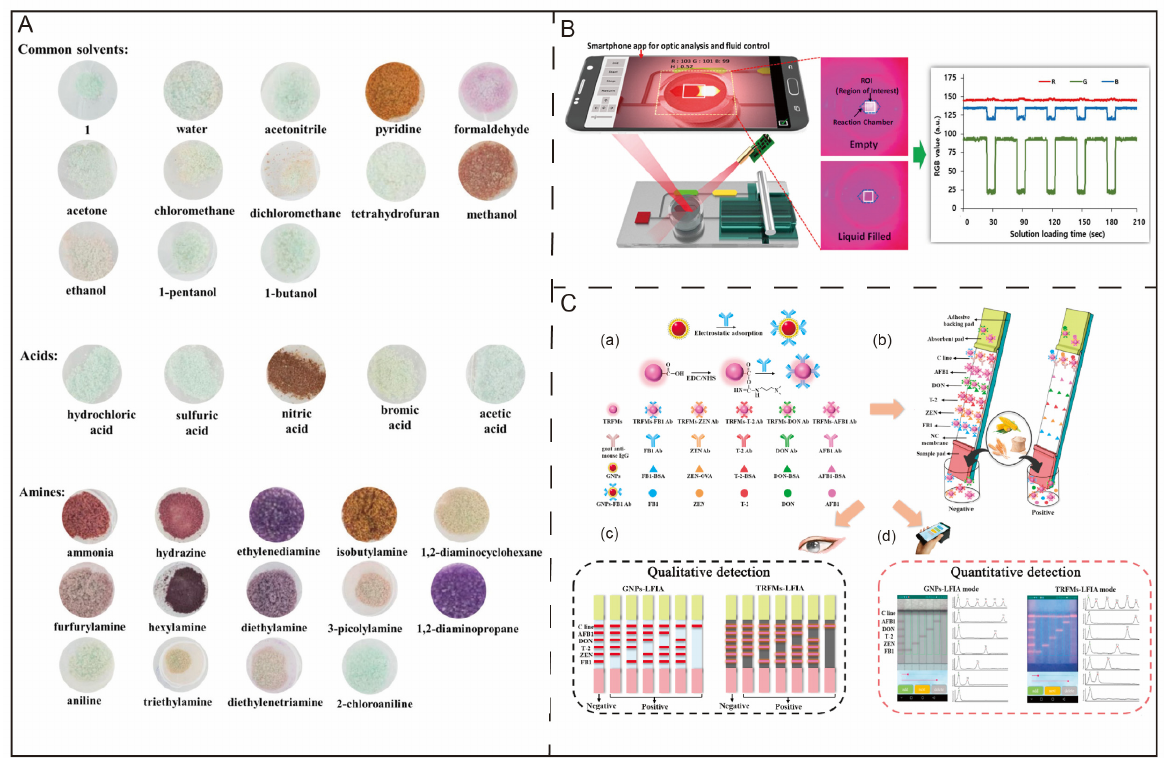
Figure 2. ( A ) Schematic of vapochromic transformation for the sensing of VOCs by Complex 1. ( B ) Illustration of the optofluidic automated 96-well LOC device. Incident light on the reaction chamber of the microfluidic device was captured by a camera, and the RGB value of ROI was analyzed with a smartphone. ( C ) Schematic diagram of smartphone-based GNPs and TRFMs-LFIAs for mycotoxin detection. ( a ) Preparation of immune probes; ( b ) detection principle of test strips; ( c ) qualitative test results with the naked eye; ( d ) quantitative test results with